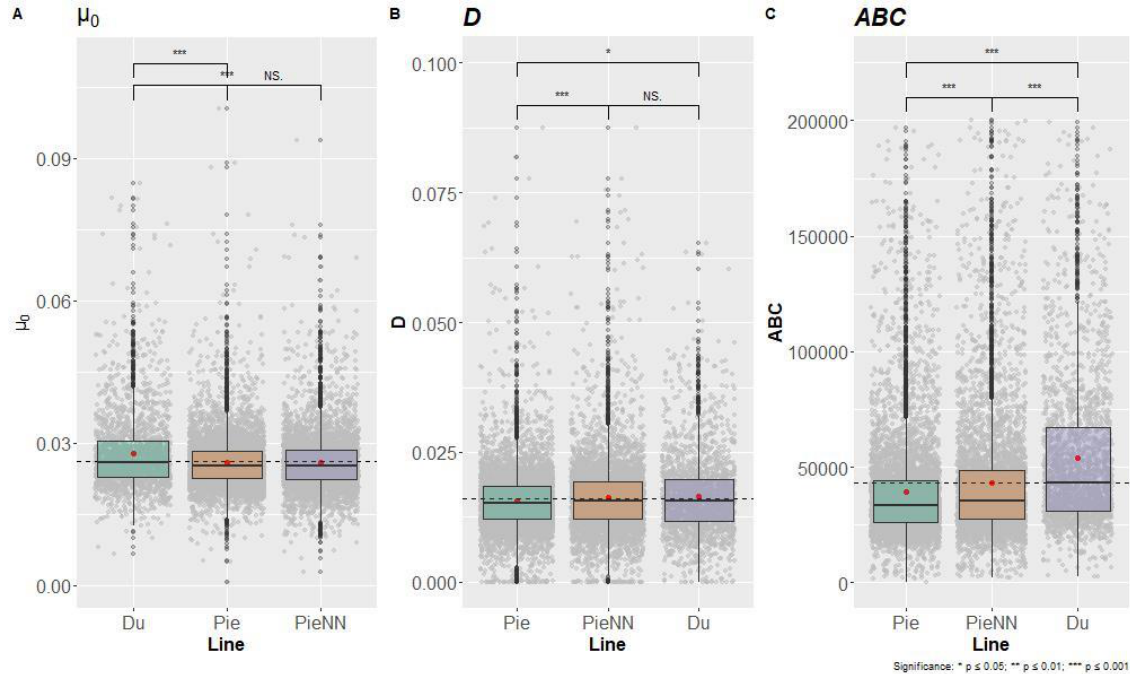
Figure 3. Comparison of µ 0 , D and ABC statistics in the three pig lines analyzed. Parameter µ 0 (A - initial growth rate value), parameter D (B – exponential rate of decay of growth rate), and parameter ABC (C – area between the perturbed and unperturbed growth curves) are represented. Red points show the average value of the model parameters for each line. The dotted line represents the global average of the parameter. Significant differences between groups are indicated as * p - value≤ 0.05, ** p - value≤ 0.01, and *** p - value≤